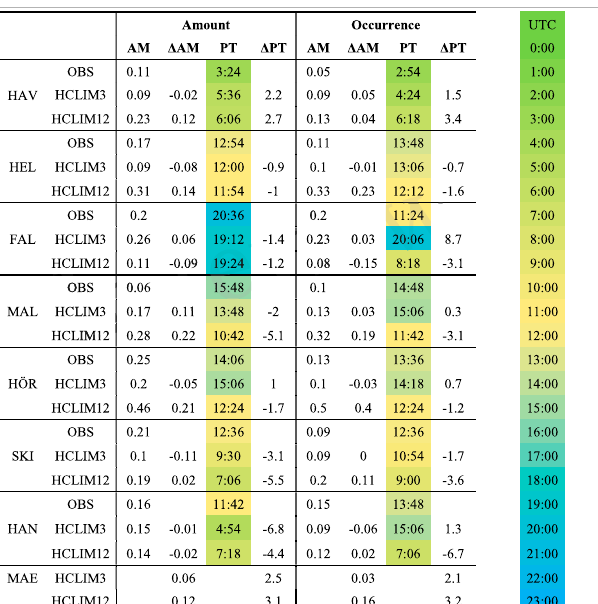
TABLE 3 | Amplitude (AM) and peak timing (PT) of rainfallamount and occurrence in each station in the observed (OBS) and simulated (HCLIM3, HCLIM12) smoothed diurnal cycles. Δ AM and Δ PT represent the difference between observedandsimulatedvaluesandtheirMeanAbsoluteError(MAE) isgiveninthe bottom. The color bar on the right denotes the time of day